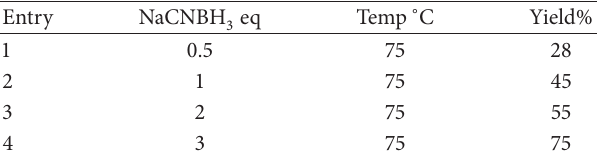
Table 5: NaCNBH 3 mole eq optimization.